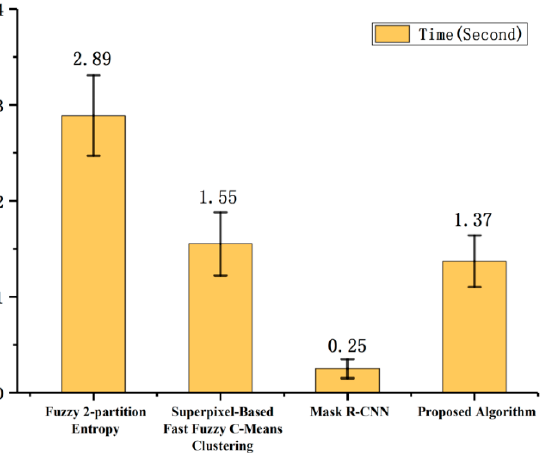
Figure 7. Computational efficiency of different methods; comparison between fuzzy 2-partition entropy, SFFCM, mask R-CNN, and the proposed algorithm.